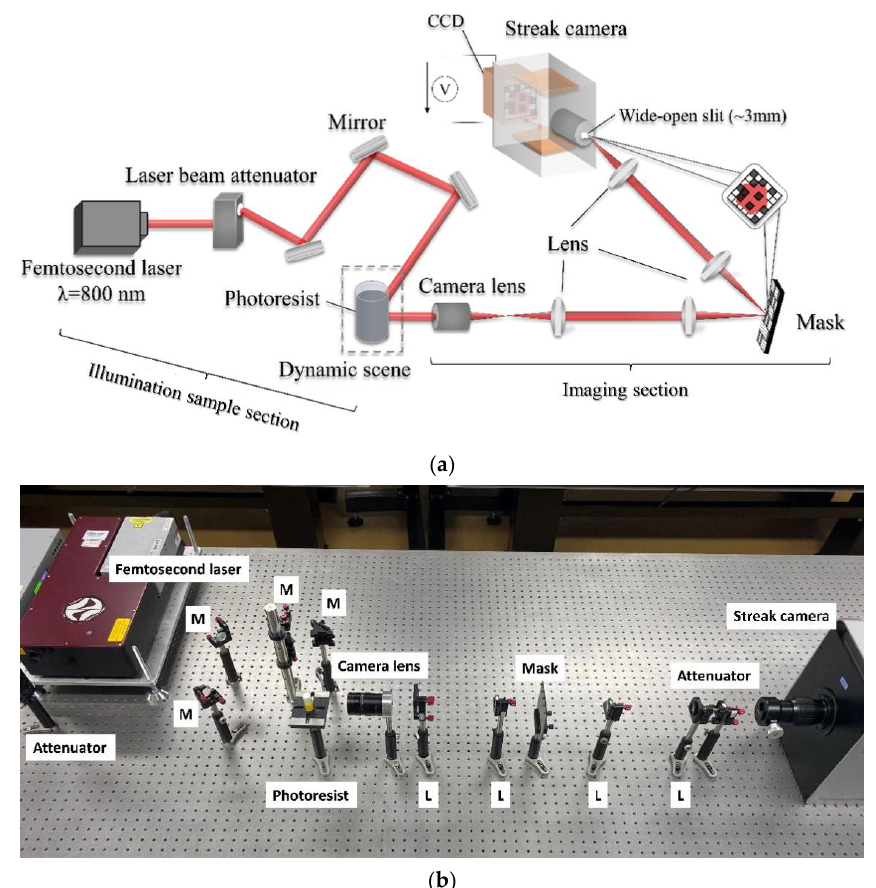
Figure 2. Experimental setup. ( a ) Experimental arrangement for observing the motion of light pulse in photoresist mixture with CUP system. ( b ) Actual optical path.